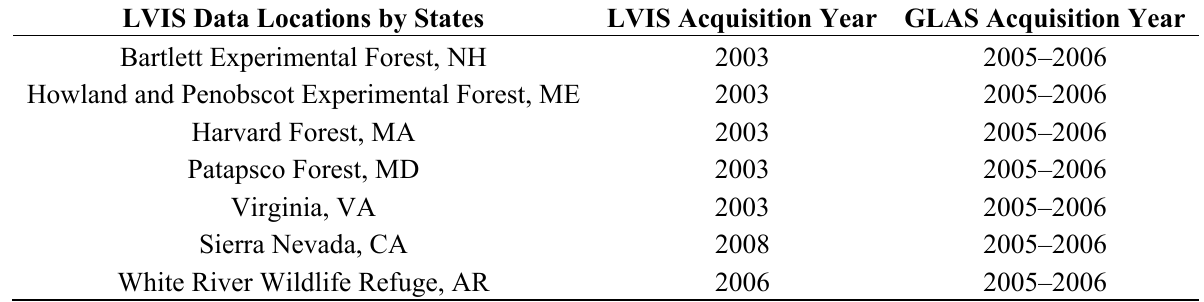
Table 2. Datasets for inter-comparisons between LVIS derived heights and GLAS height